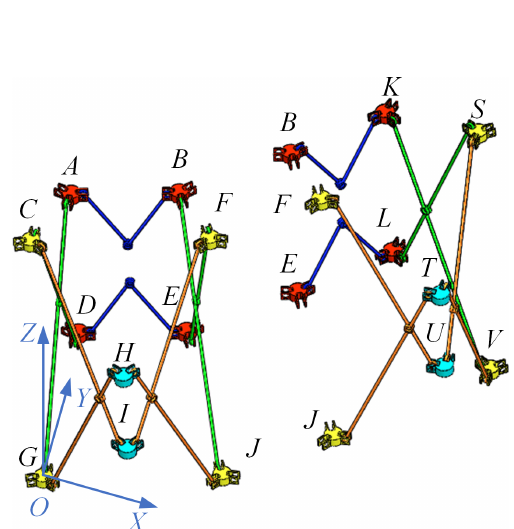
Figure 8. Proportional diagram of the height of the node.